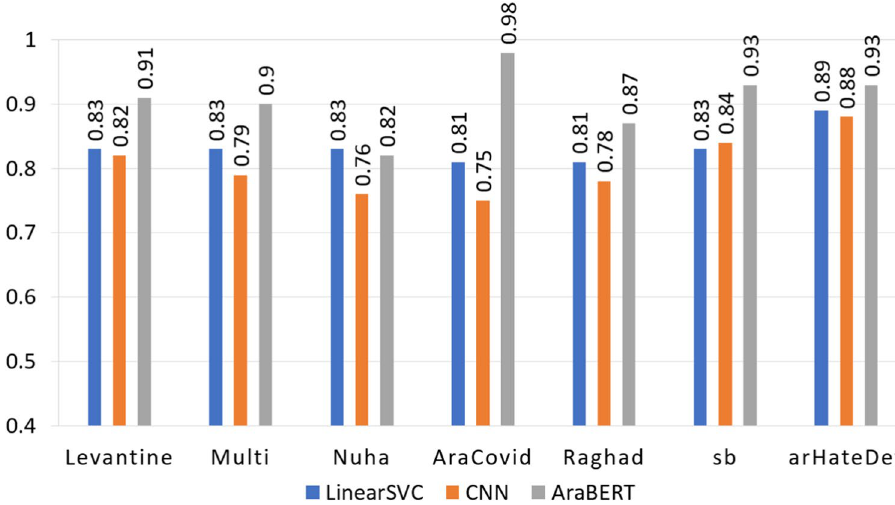
Fig. 6 Comparison between deep learning models with the best performing machine learning